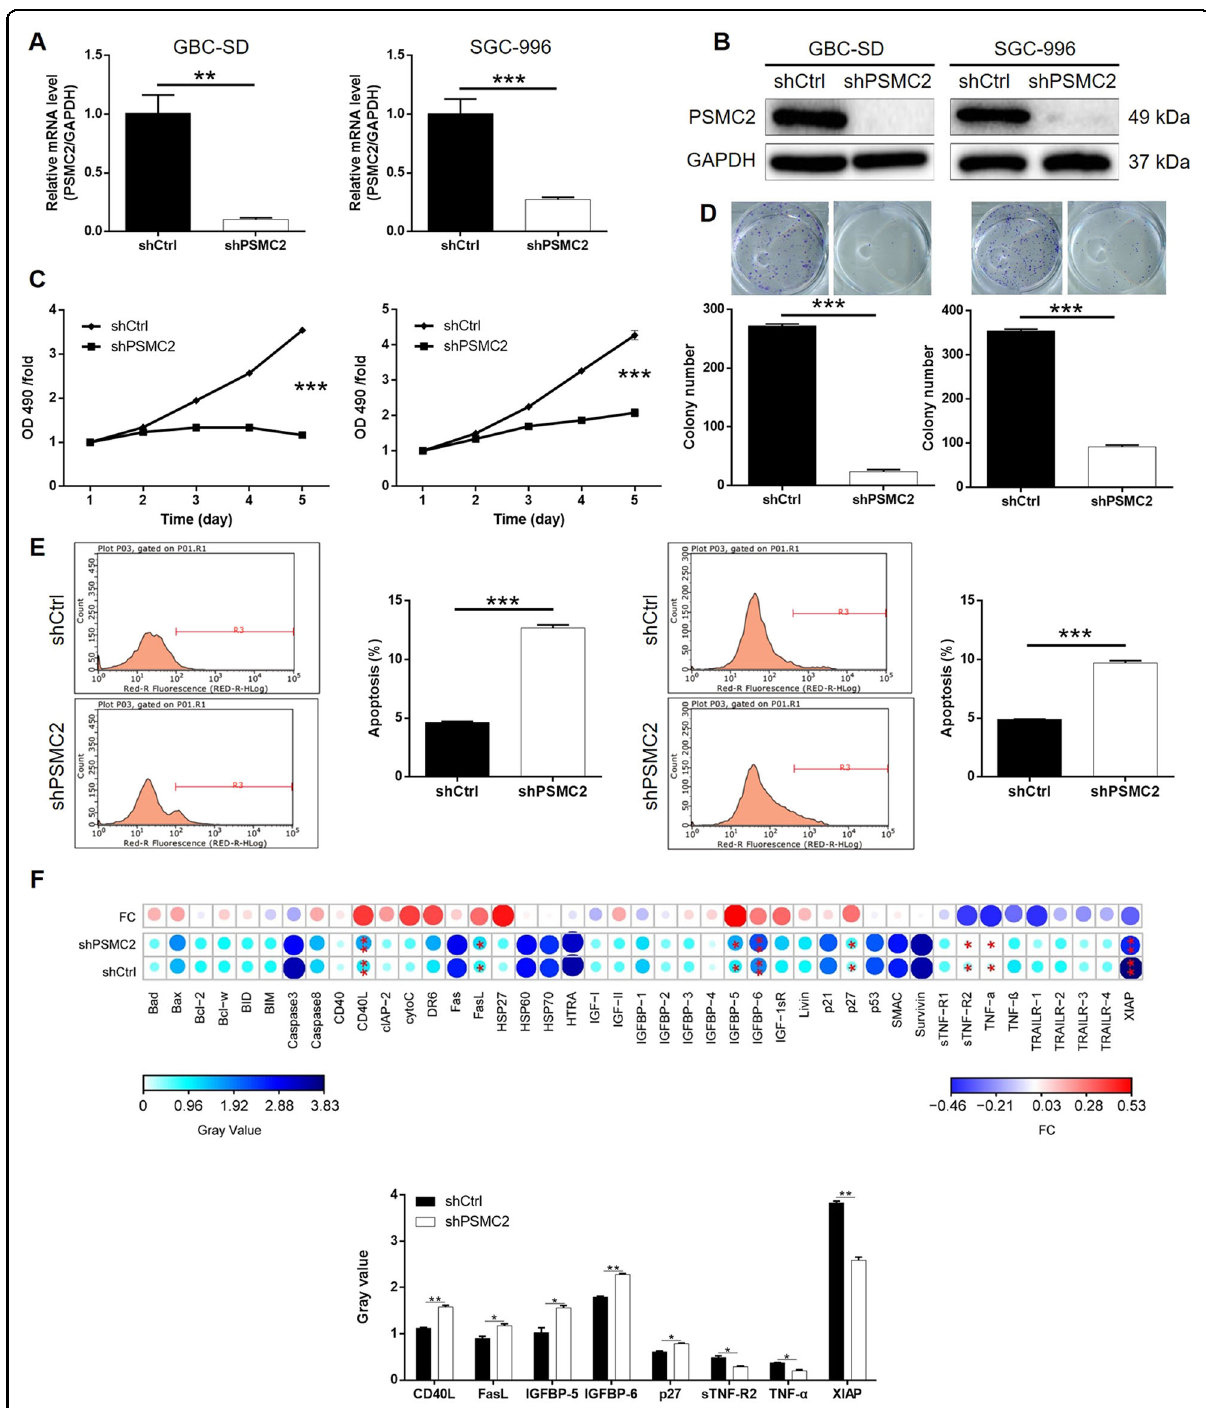
Fig. 2 PSMC2 knockdown inhibited GBC development in vitro. A , B Cell models with or without PSMC2 knockdown were constructed by transfecting shPSMC2 or shCtrl. The knockdown ef fi ciency of PSMC2 in GBC-SD and SGC-996 cells was assessed by qPCR ( A ) and western blotting ( B ). C MTT assay was employed to show the effects of PSMC2 on cell proliferation of GBC-SD and SGC-996 cells. D Plate clone formation assay was applied to investigate the effects of PSMC2 knockdown on colony formation ability of GBC-SD and SGC-996 cells. E Flow cytometry was performed to detect cell apoptosis of GBC-SD and SGC-996 cells with or without PSMC2 knockdown. F Human apoptosis antibody array was utilized to analyze the regulatory ability of PSMC2 on the expression of apoptosis-related proteins in GBC-SD cells. Data were shown as mean ± SD. * P < 0.05, ** P < 0.01, *** P <